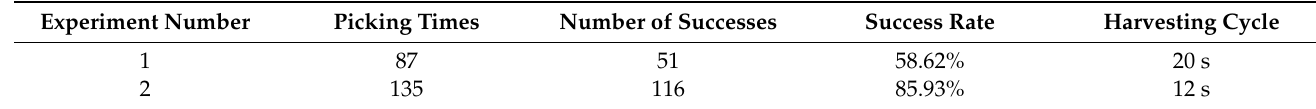
Table 2. Experimental table comparing different path planning